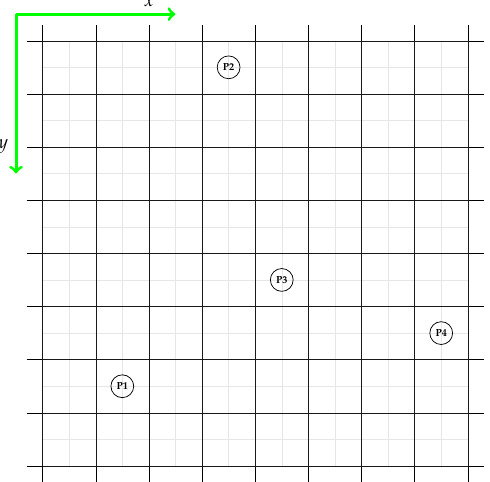
Figure 6. Picking N g = 4 end-points for multilateral well placement